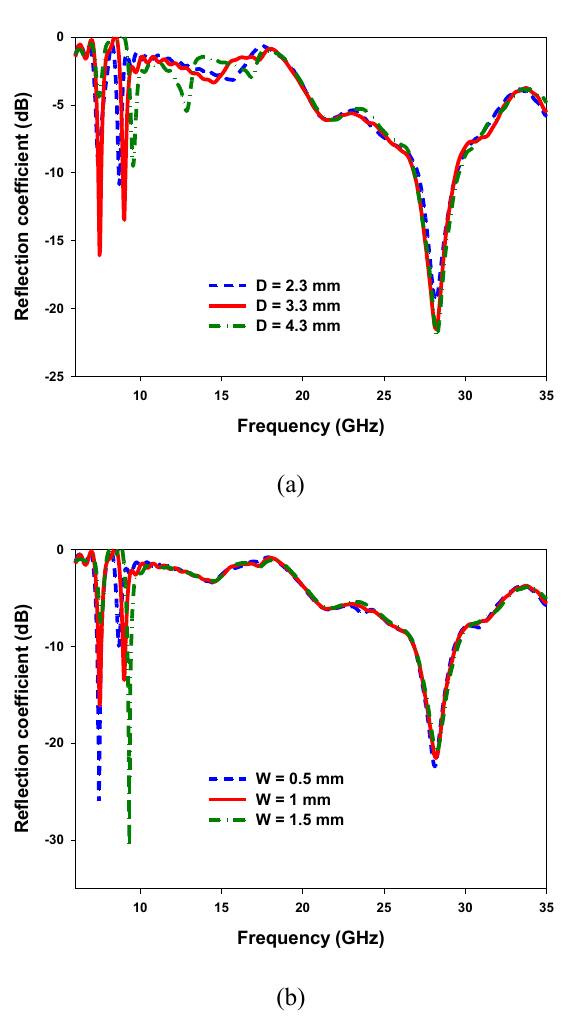
FIGURE 6. Effect of Slot 3 (a) variation of D parameter, (b) variation of W parameter.